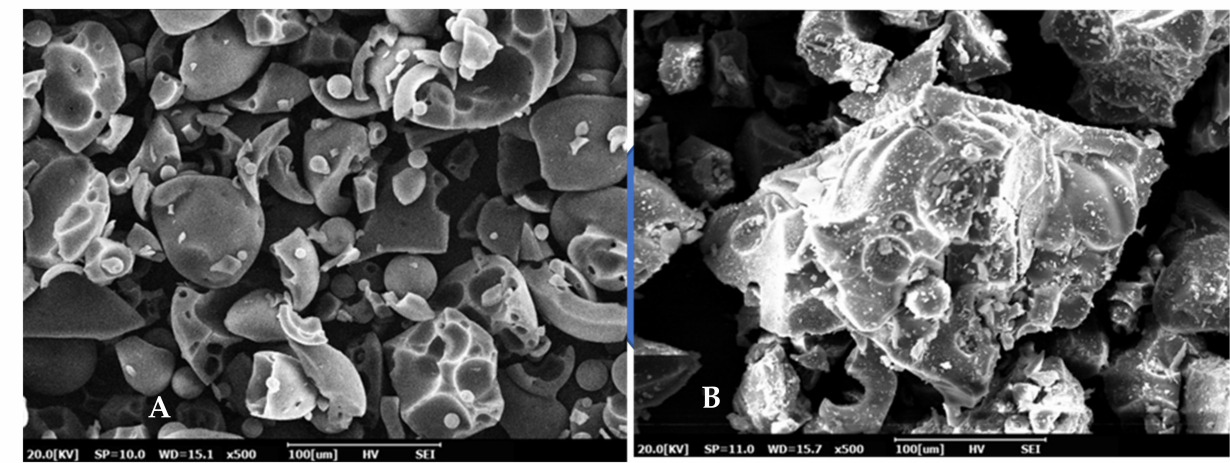
Figure 10. Morphology of pure lignin ( A ) before modification, and lignin after modification by phthalic anhydride ( B